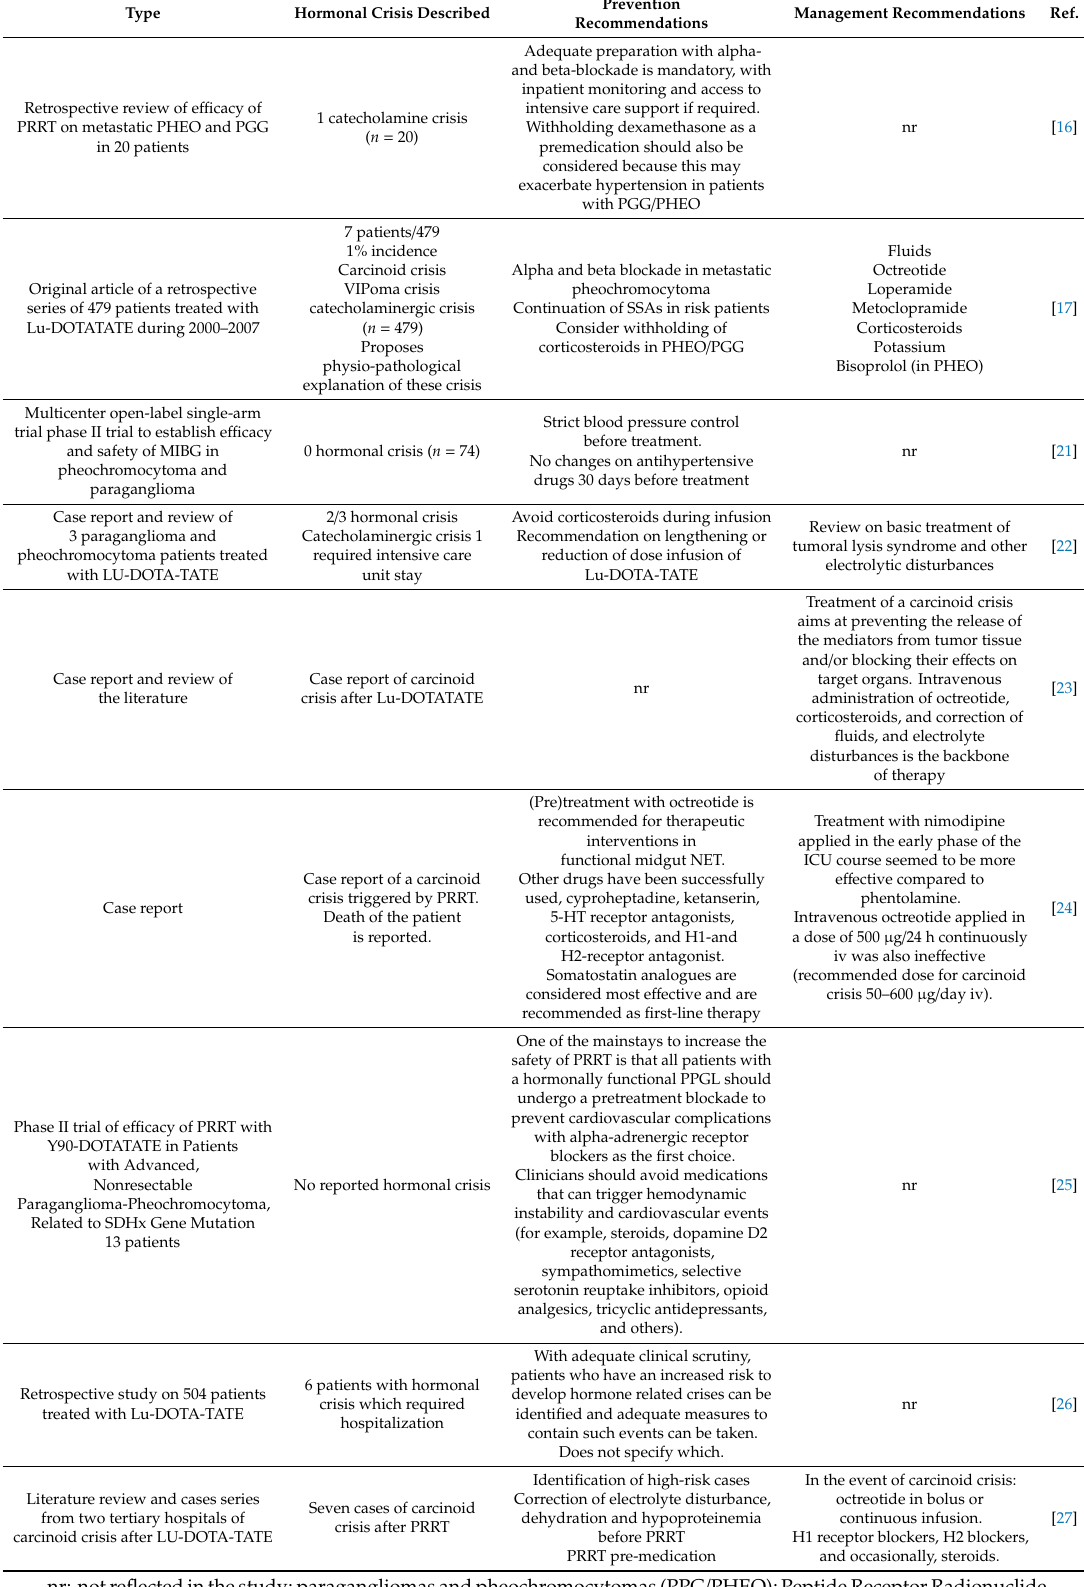
Table 2. Articles selected in this systematic